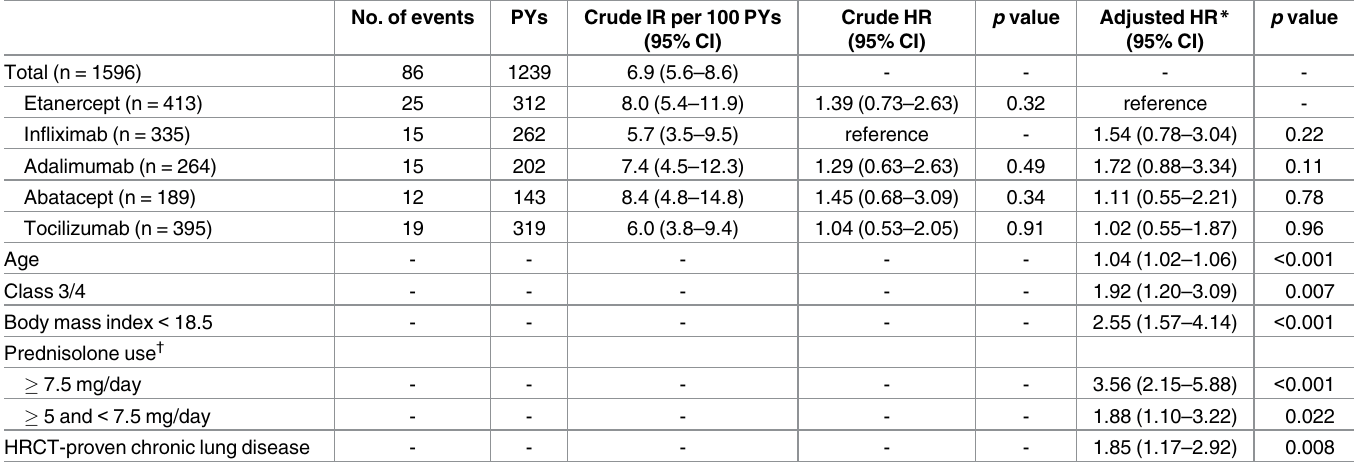
Table 3. Comparison of the risk of hospitalized infection during the first year of follow-up between treatment groups of RA